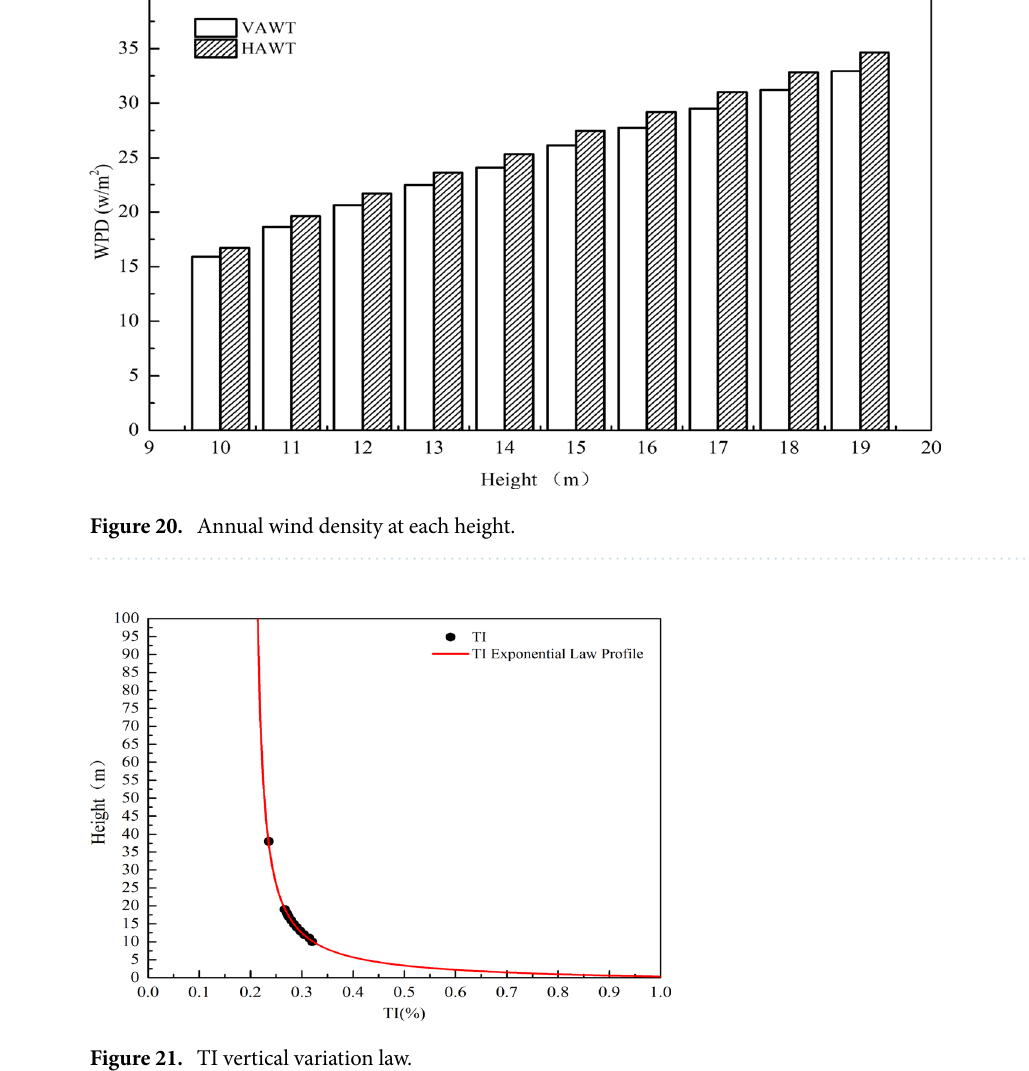
Figure 21. TI vertical variation